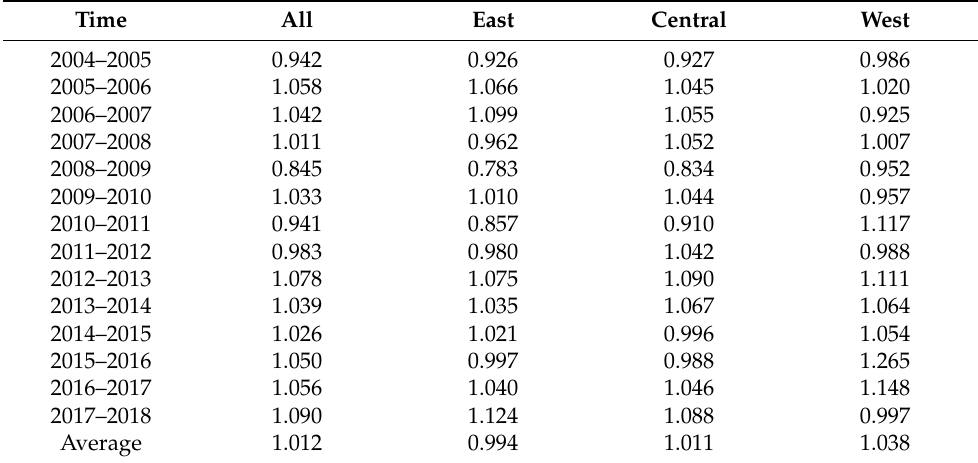
Table 2. Total factor productivity change (TFPC) of forestry in China from 2004 to 2018. Time All East Central